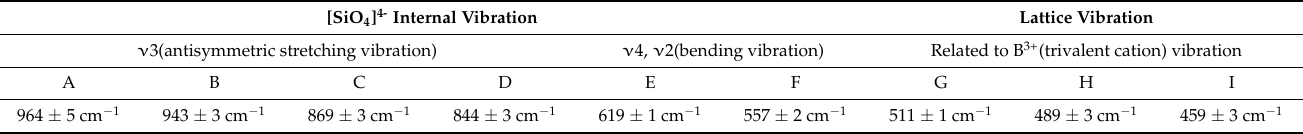
Table 3. Chromium–vanadium grossular infrared spectrum peak Table 3. Chromium – vanadium grossular infrared spectrum peak assignment.